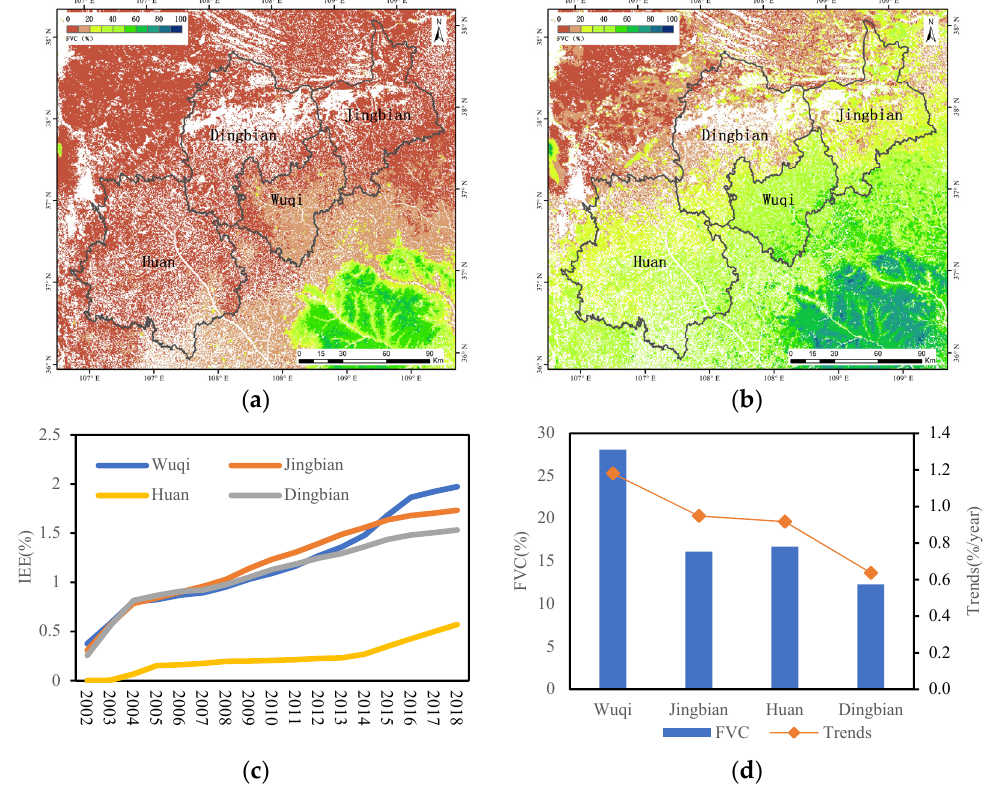
Figure 13. ( a ) is the 2000 year and the ( b ) is the 2019 year of the Spatial distribution of FVC in Wuqi and the surrounding county typical area. ( c ) The intensity of ecological afforestation (IEE) of each county in Wuqi and the surroundings. ( d ) The FVC and trends of each county in Wuqi and the surroundings. Table 2. Correlation between FVC and afforestation engineering intensity in typical areas. * indicates the significance of the correlation test. 0.01 * represents a significant correlation at the 0.01 level. 0.05 * represents a significant correlation at the 0.05